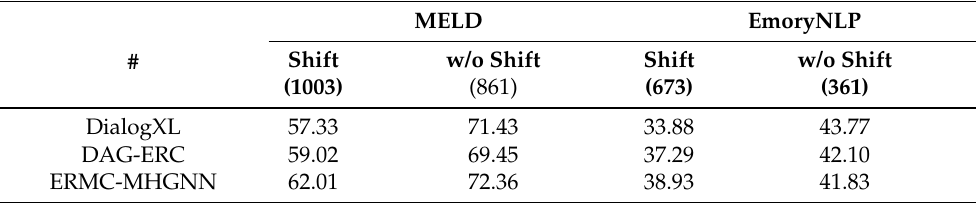
Table 5. Test accuracy of ERMC-MHGNN and the partial baseline models on samples with an emotional shift and without one. ’()’ indicates the number of